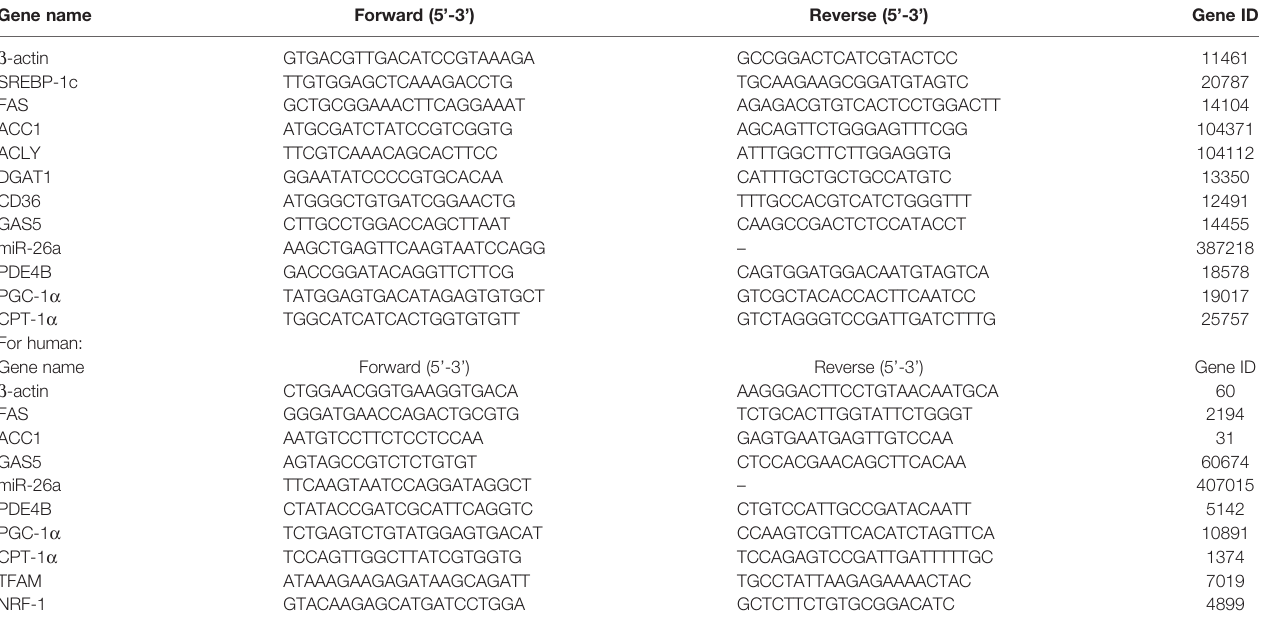
TABLE 2 | Primers used for qPCR in the study: For